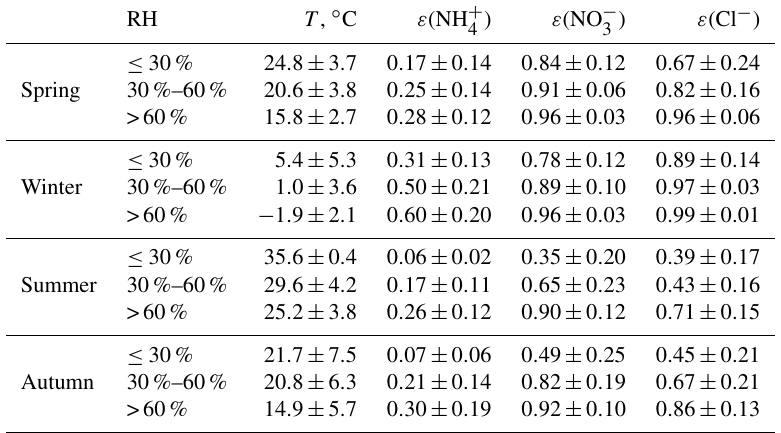
Table 3. Average measured ε (NH + ambient RH levels in four seasons.